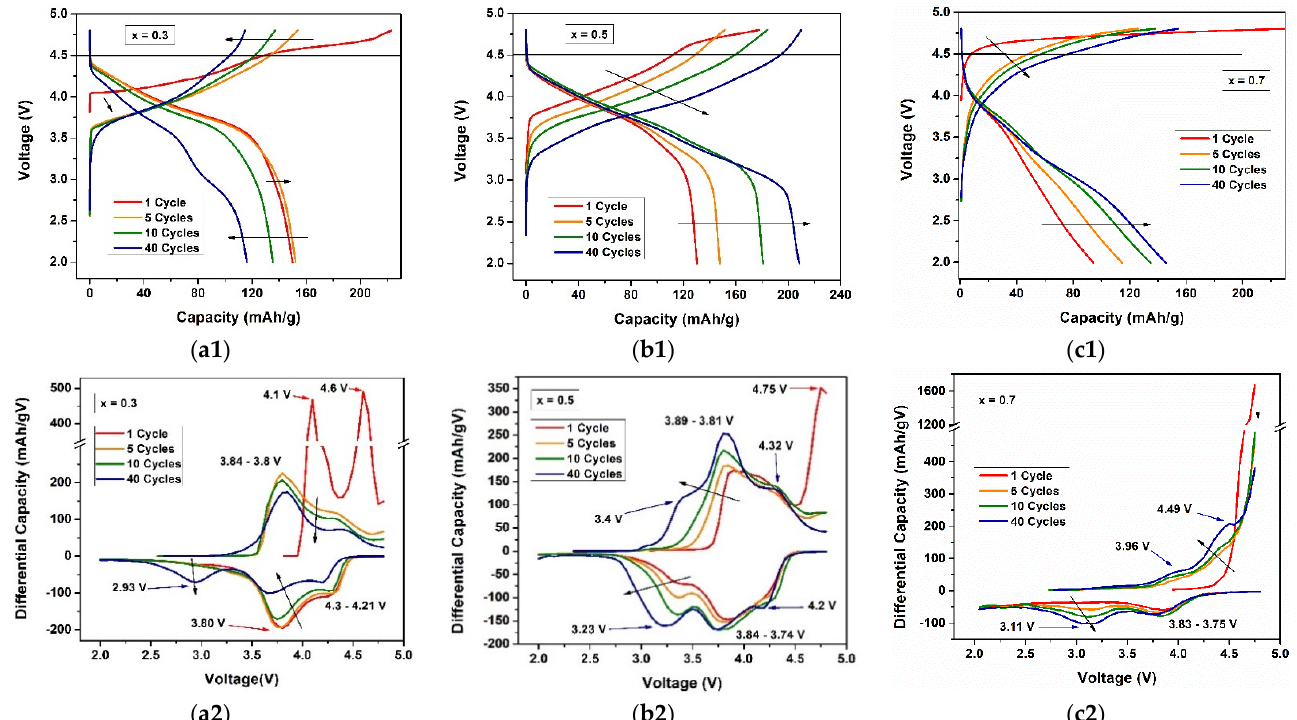
Figure 6. Charge–discharge profiles ( a1 – c1 ) and differential capacity plots ( a2 – c2 ) for the 1st, 5th, 10th, and 40th cycles for ( a ) 0.3Li 2 MnO 3 –0.7LiNi 0.5 Mn 0.5 O 2 , ( b ) 0.5Li 2 MnO 3 –0.5LiNi 0.5 Mn 0.5 O 2 , and ( c ) 0.7Li 2 MnO 3 –0.3LiNi 0.5 Mn 0.5 O 2 cathode materials.